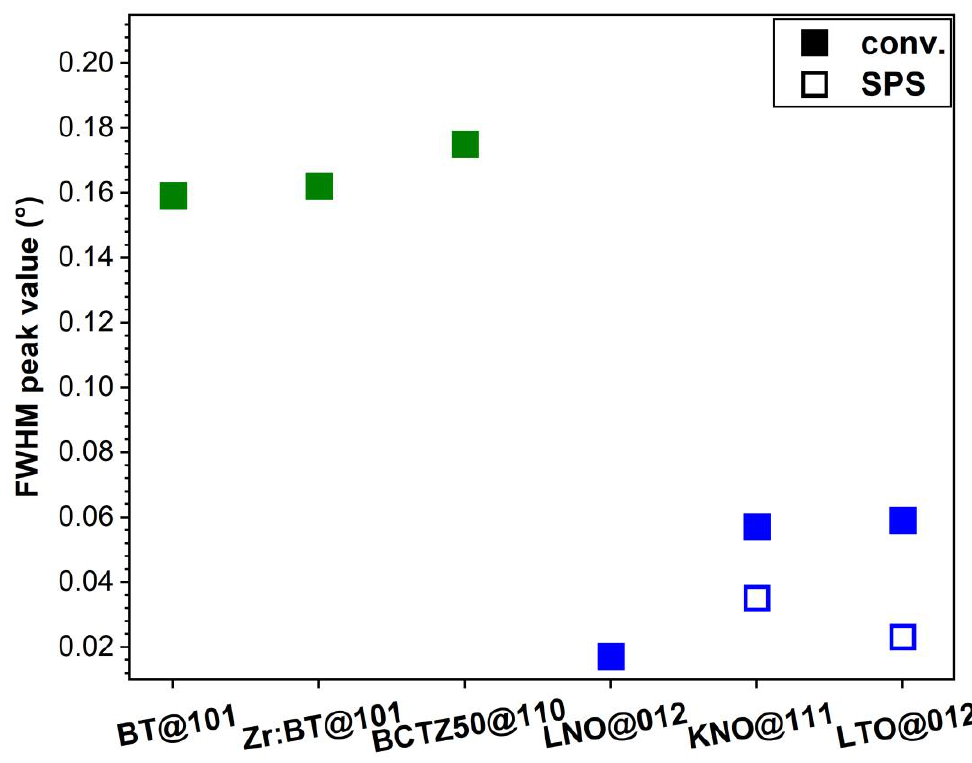
Figure 2. FWHM values of the most intense diffraction peak of each ceramic sample, sintered either conventionally (conv.) (solid symbols) or by SPS (hollow symbols).